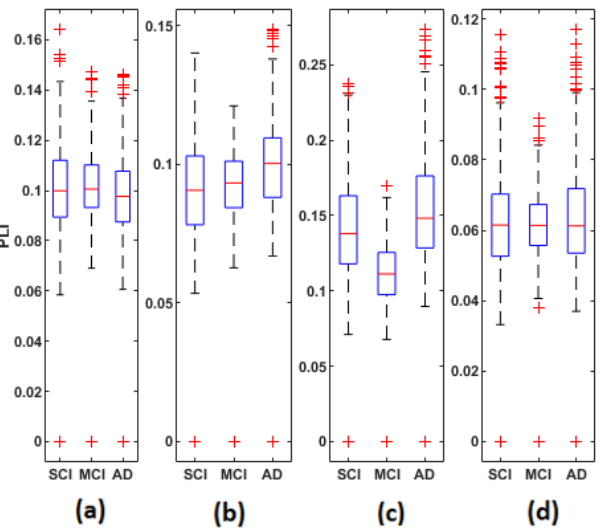
Figure 6. Boxplots of PLI values averaged over all subjects of the SCI, MCI and AD groups on the